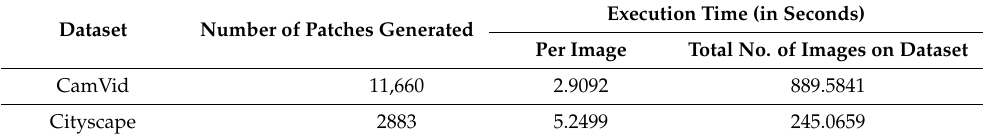
Table 6. Classification execution time.